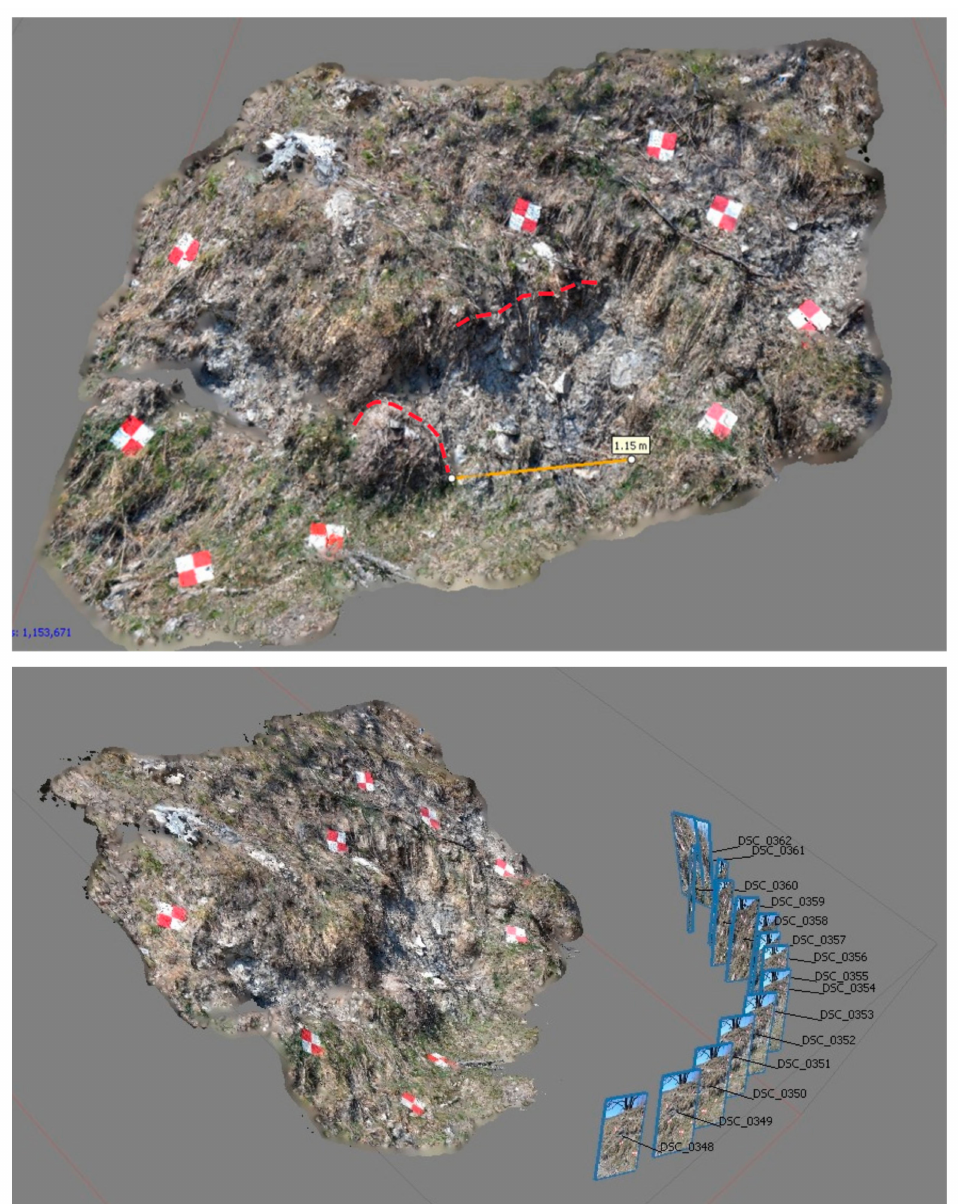
Figure 11. 3D-reconstruction of a local portion of the right-side fissure (see Figure 9 to locate the site), processing terrestrial photos ( Up : manual displacement measure; down : positions of image